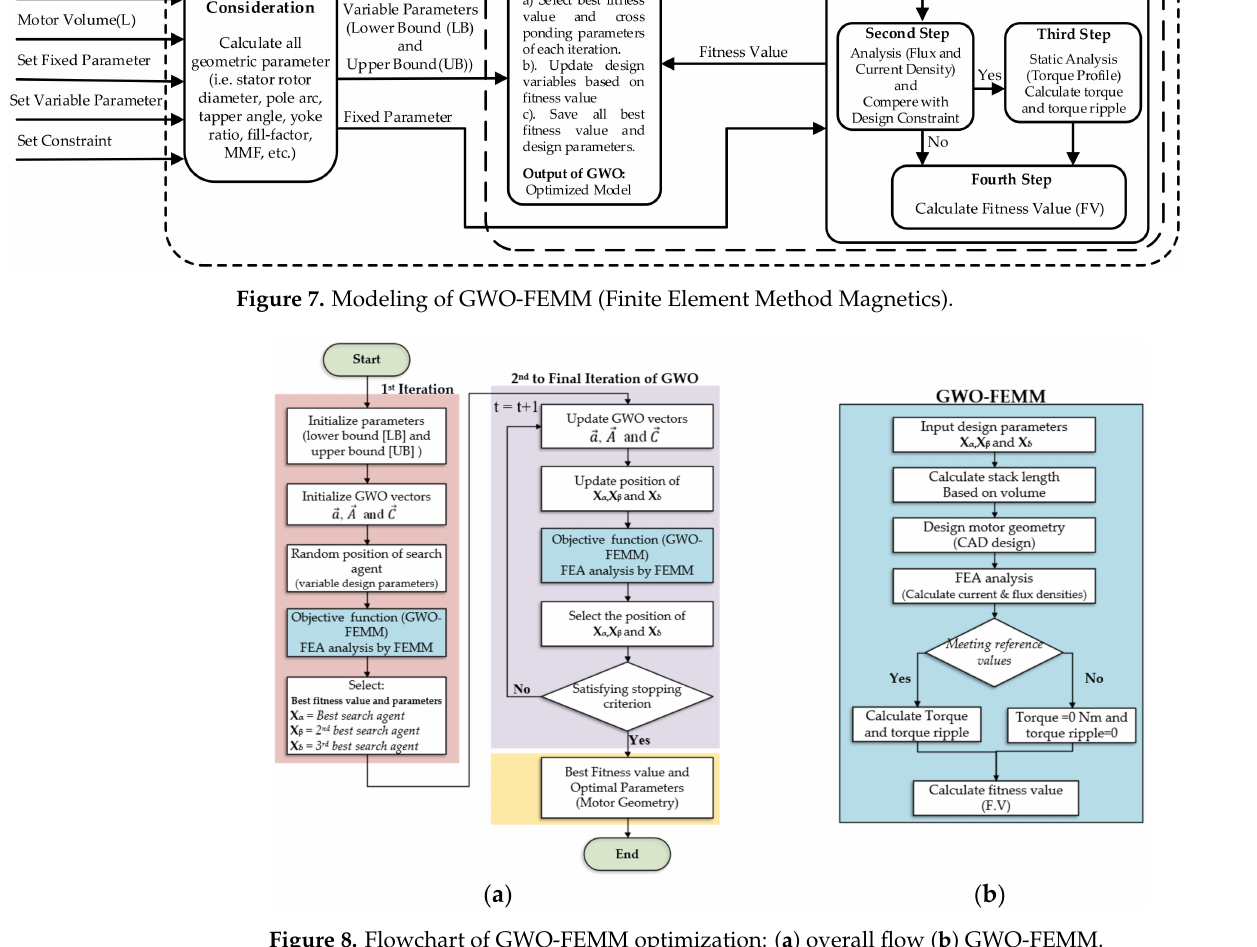
Figure 8. Flowchart of GWO-FEMM optimization: ( a ) overall flow ( b )